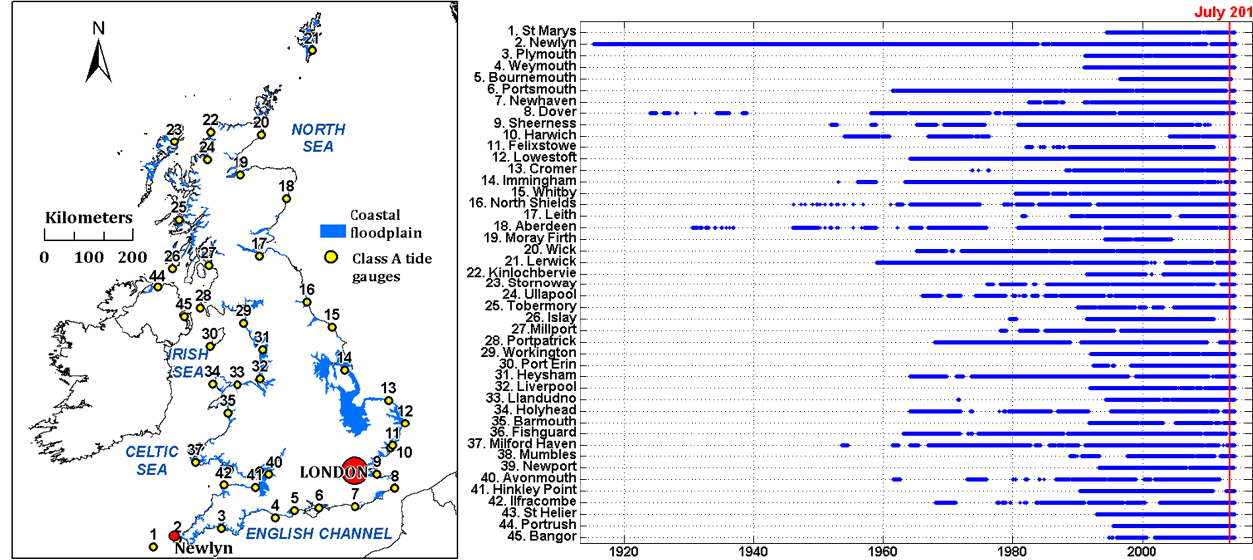
Figure 1. (a) Location map of Newlyn also showing the main seas around the UK and land broadly classified as at risk from coastal flooding (below 5m Ordnance Datum Newlyn); (b) data coverage at the tide gauge locations including for the 2013/14 assessment. 3